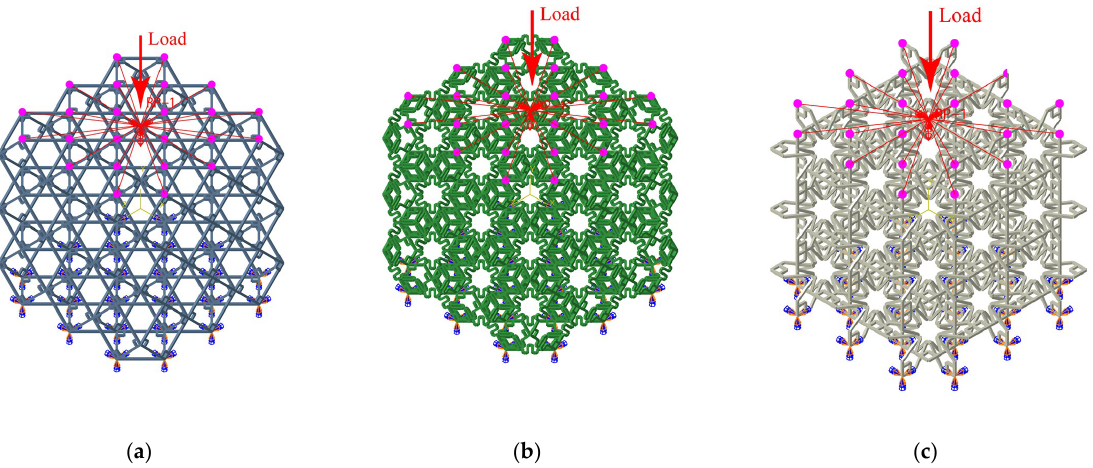
Figure 4. The finite element models of the three types of fundamental cells for macro-mechanical performance analysis, for instance, with 3 × 3 × 3 unit cells: ( a ) Rigid lattice; ( b ) Compliant lattice; and ( c ) Auxetic lattice. Table 1. Mechanical property parameters of the material.